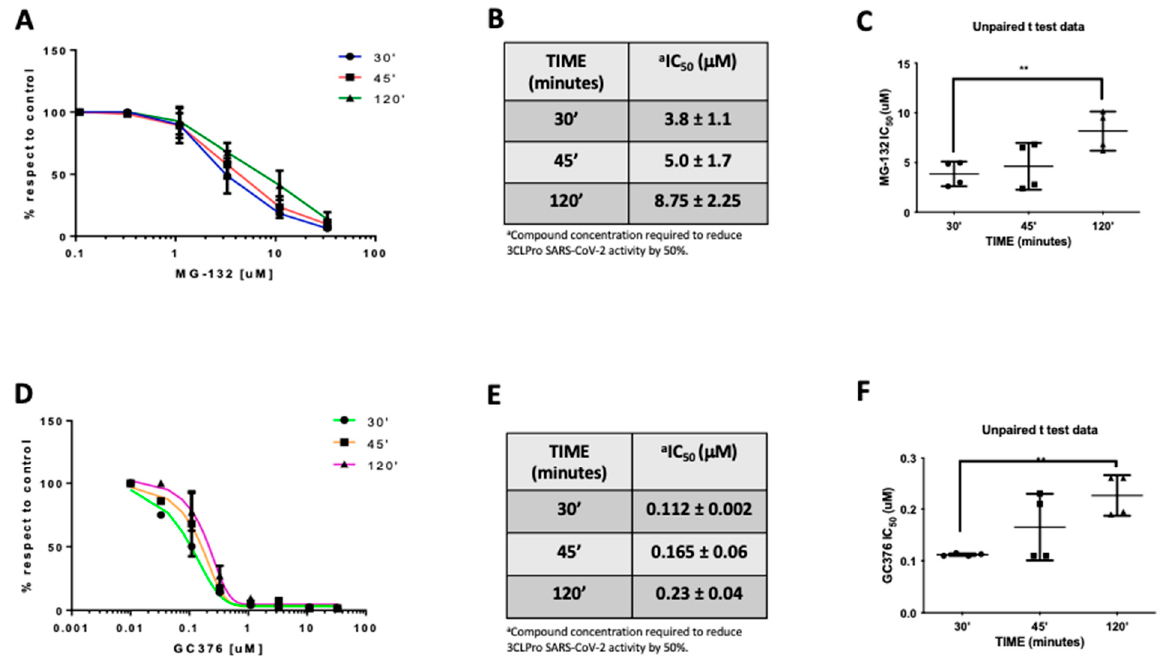
Figure 4. MG-132 and GC367 activities on SARS-CoV-2 MPro at different preincubation times. ( A ) MG-132 dose-dependent curves. ( B ) IC 50 values ( µ M concentrations). ( C ) t -test of MG-132 IC 50 values; ( D ) GC376 dose-dependent curves. ( E ) IC 50 values ( µ M concentrations). ( F ) t -test of GC376 IC 50 values.